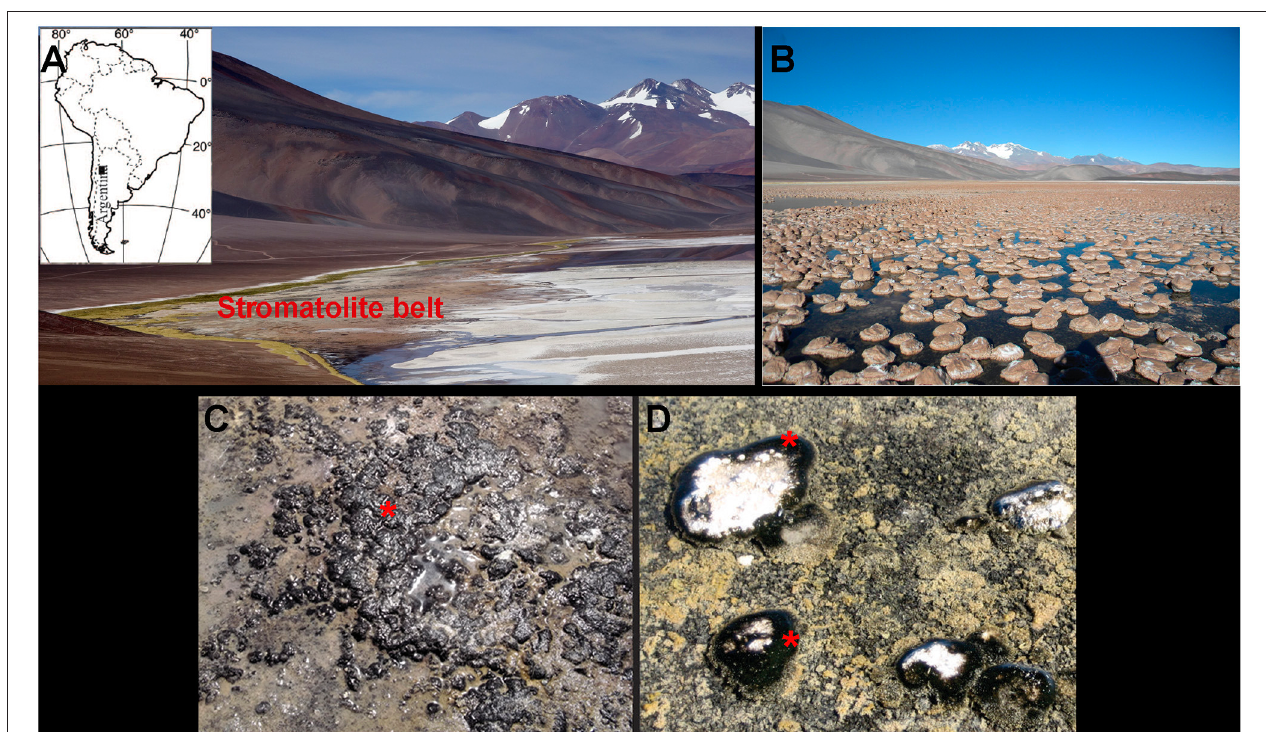
FIGURE 1 | (A) Location map of the Laguna Negra (LN) lake in the Catamarca province, Argentina (indicated by a black square) along with a panoramic view of the lake shore and the stromatolite belt. (B) Close view of the subspherical oncoids that compose the stromatolite belt. (C) Emerged black pustular (BP) mat and (D) BP mat covering the periphery of partly emerged oncoids (red